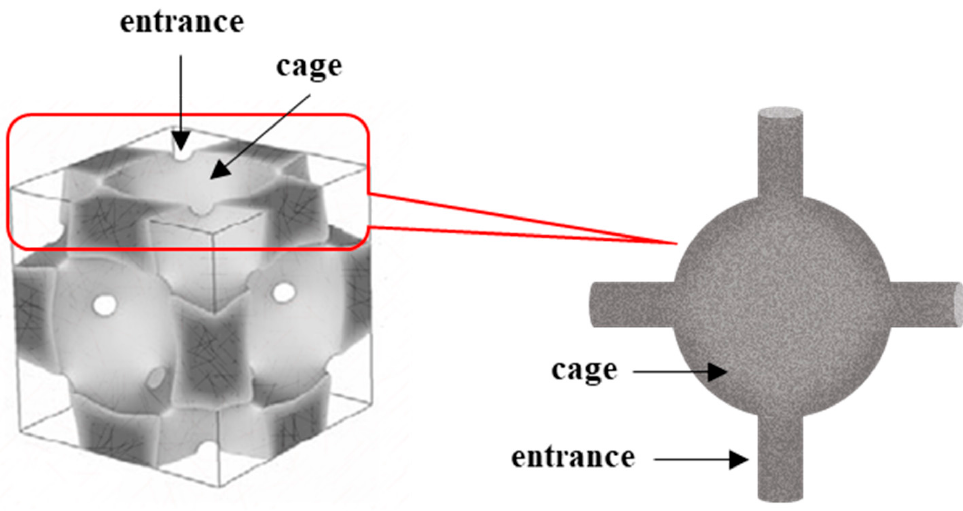
Figure 1. Structure of KIT-5 material ( left side ) and scheme of pore system characteristics of this type of material ( right side ).